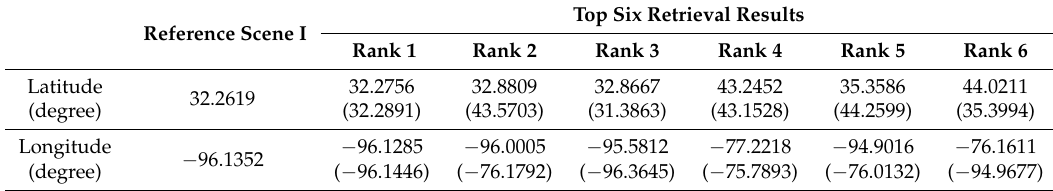
Figure 4. Reference scene I over Cedar Creek Reservoir in Texas. ( a ) The scene in NLCD 2006; ( b ) The remotely sensed image taken from Google Earth on the same region of the reference scene shown in ( a ) (for visualization, the histogram of the image has been stretched). Table 1. The geographic coordinates of the center pixels in the top six returned scenes with reference scene I. Coordinates included in the brackets were acquired by [28], and the others are the results of the proposed